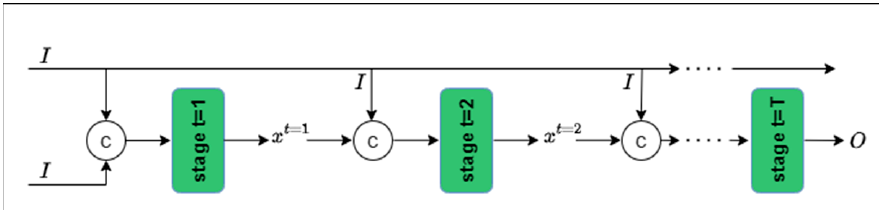
Figure 3. Progressive network architecture.